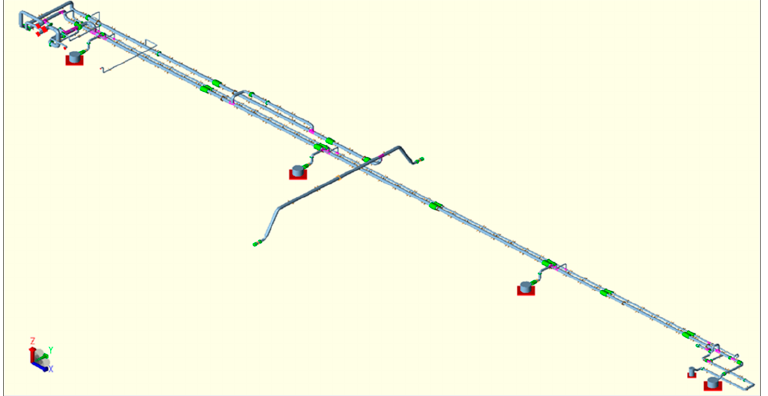
Figure 5. Geometry and finite element model of piping system.